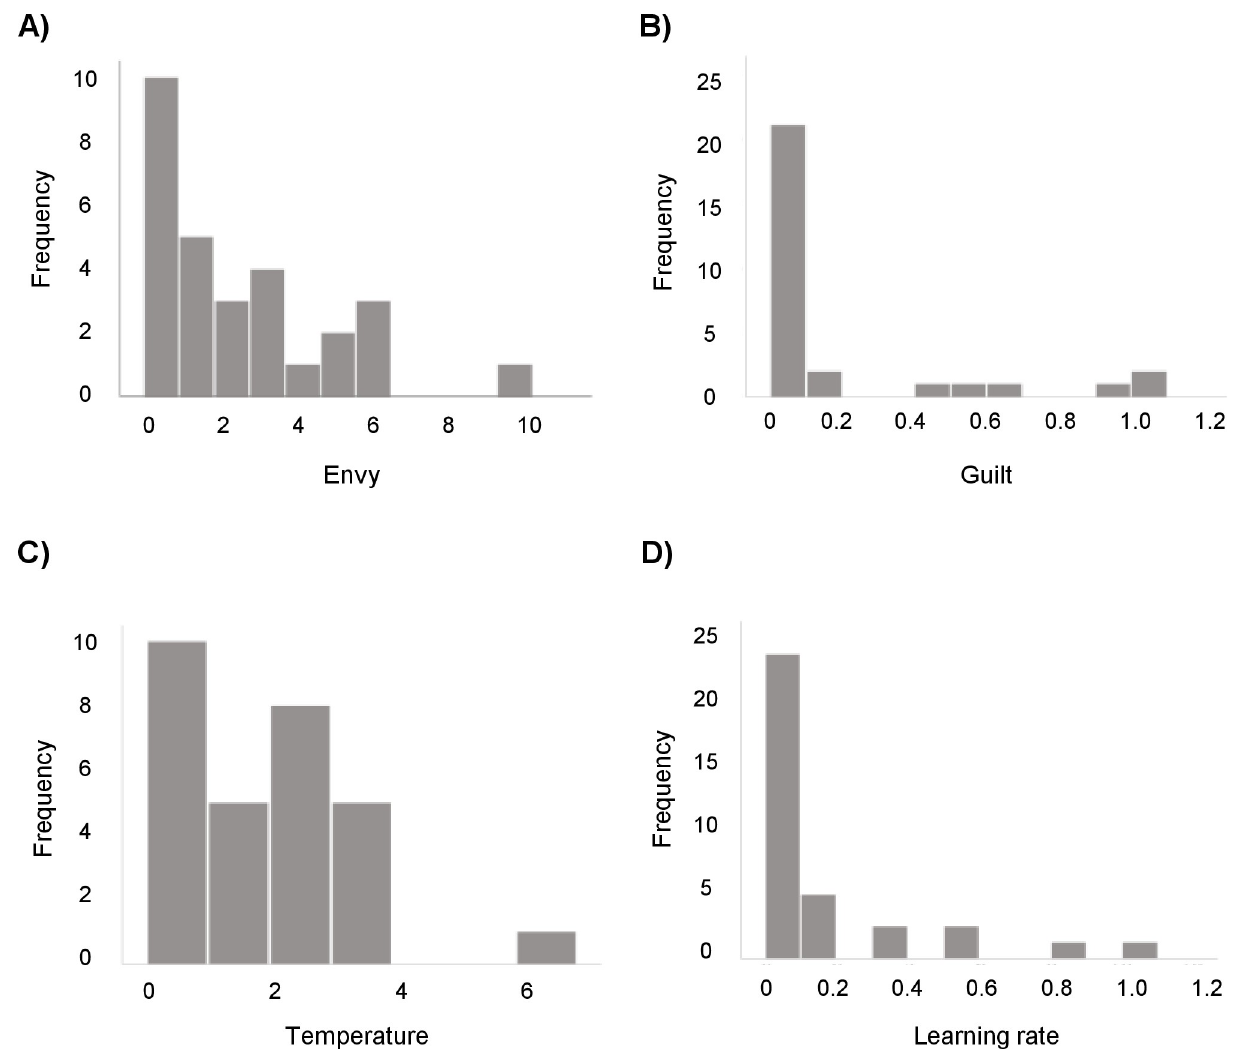
Fig 4. Distribution of the free parameters for the winning